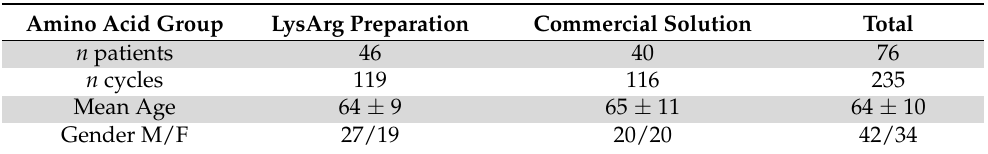
Table 2. Demographic data. There were no significant differences between groups for age and sex-ratio.